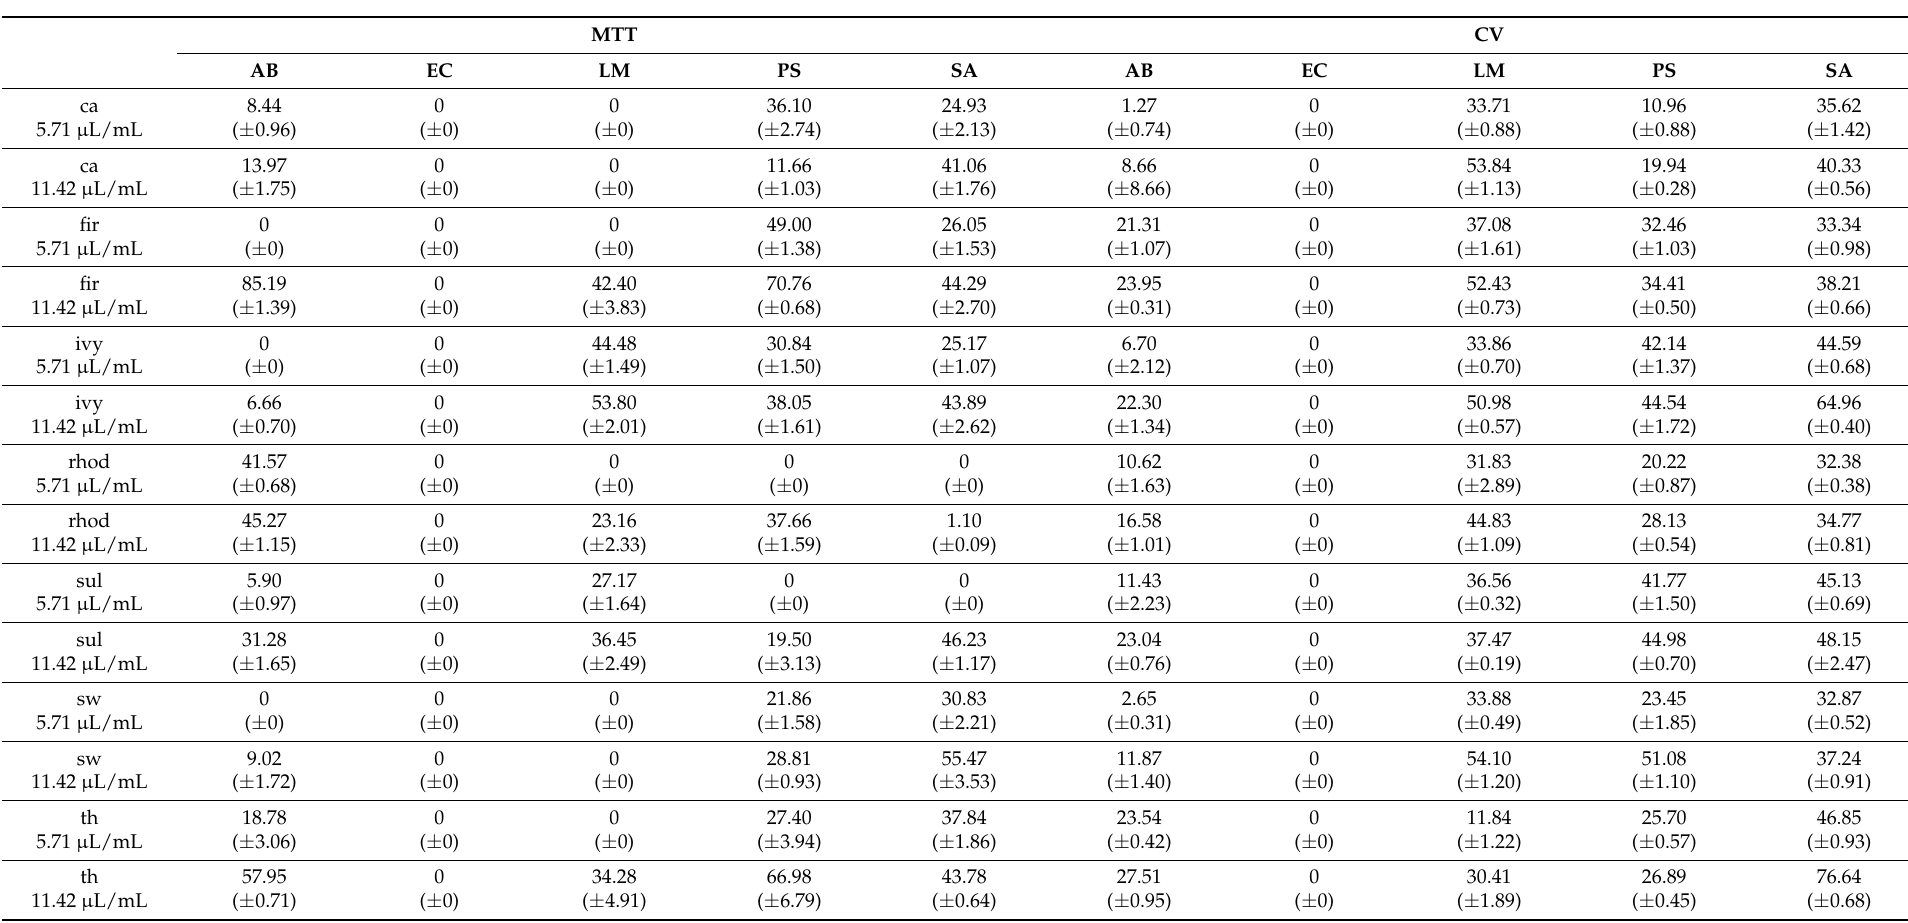
Table 5. Inhibitory activity of the monofloral honeys, tested at 5.71 µ L/mL and 11.42 µ L/mL, on the inhibitory capacity on mature biofilm by five pathogenic bacteria. Results are expressed as percentage (average ± SD) and calculated assuming for the control (untreated bacteria) an inhibition value = zero. Legend: ca: cardoon honey; fir: fir honey; ivy: ivy honey; rhod: rhododendron honey; sul: sulla honey; sw: strawberry tree honey; th: tree of heaven honey. AB: A. baumannii ; EC: E. coli ; LM: L. monocytogenes ; PS: P. aeruginosa ; SA: S. aureus. MTT: data of the inhibitory action exhibited by the honey on bacterial metabolism, evaluated through the MTT test; CV: data of the inhibitory action exhibited by the honeys on the biofilm, evaluated through the Cristal violet